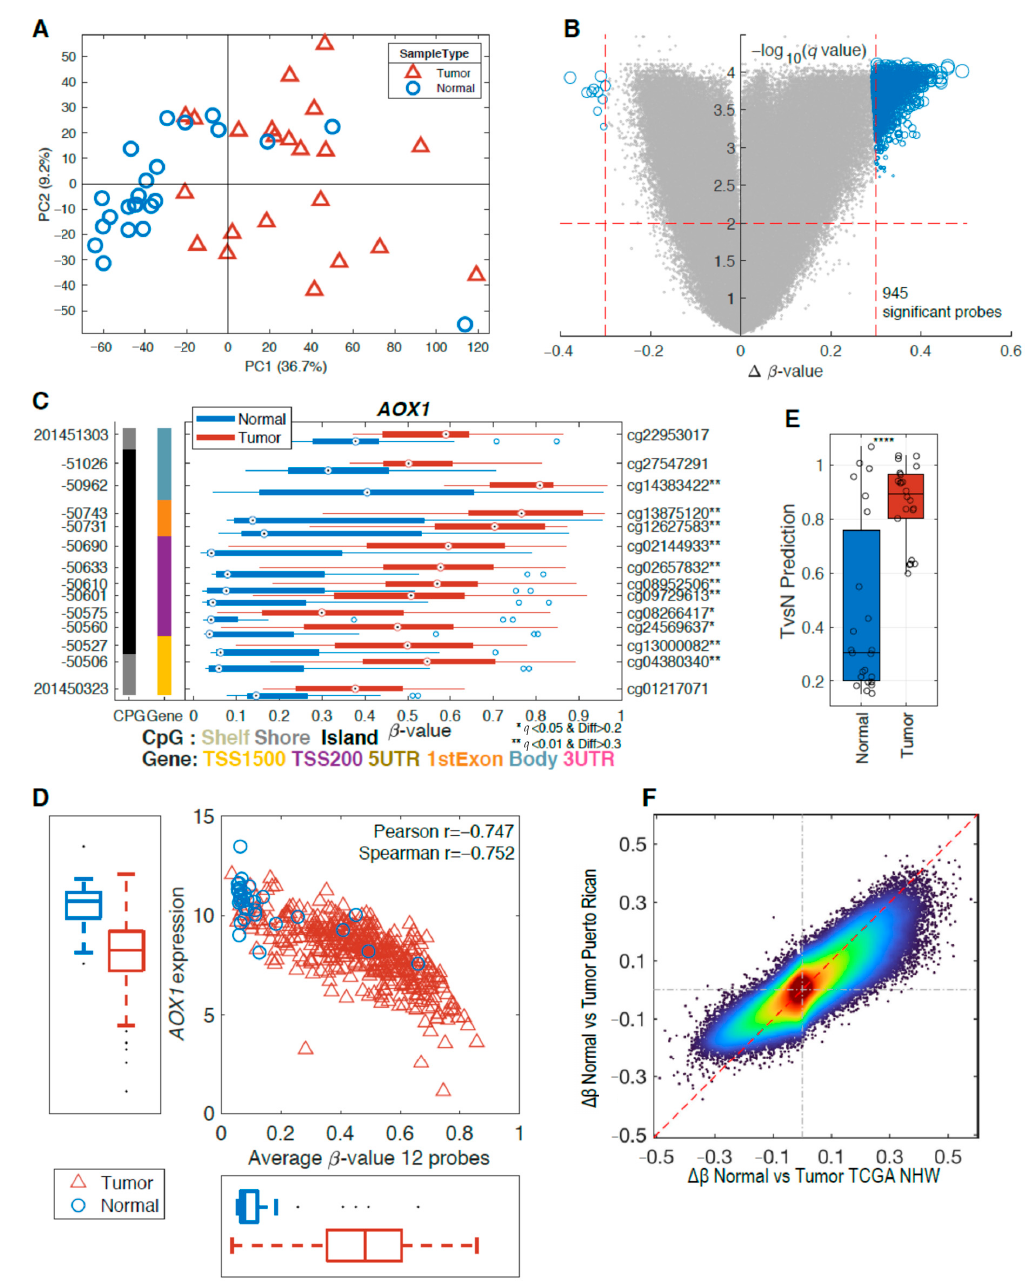
Figure 1. Methylation differences in tumors vs. normal tissue. ( A ) Principal component analysis (PCA) of 45 samples in our study shows a separation between tumor (red triangles, n = 22) and adjacent normal tissue (blue circles, n = 23). ( B ) The volcano plot above indicates changes in the methylation pattern between normal and tumor tissues with hypermethylated regions in tumors. ( C ) Gene structure methylation (GSM) plot for a representative gene, AOX1 . The methylation level ( x -axis) for each probe set is represented by a boxplot for each group with tumors in red and normal in blue. The genomic and the probe identifier (ID) are shown on the left and right y -axis, respectively. The far-left column (black) indicates the presence of a CpG island and the next column (colored) shows the CpG probe location in the gene. Multiple probes showed significant differential methylation level. ( D ) Average methylation level for 12 probes vs. RNA-seq gene expression levels show a negative correlation using The Cancer Genome Atlas Prostate Adenocarcinoma (TCGA-PRAD) non-Hispanic white (NHW) samples. ( E ) Partial least squares (PLS) model derived using TCGA NHW samples can clearly separate the samples from the Puerto Rico (PR) cohort. ( F ) Density scatter plot of ∆ β -values for overlapping probes for the TCGA Illumina 450K probes vs. PR cohort (EPIC) probes. **** p <